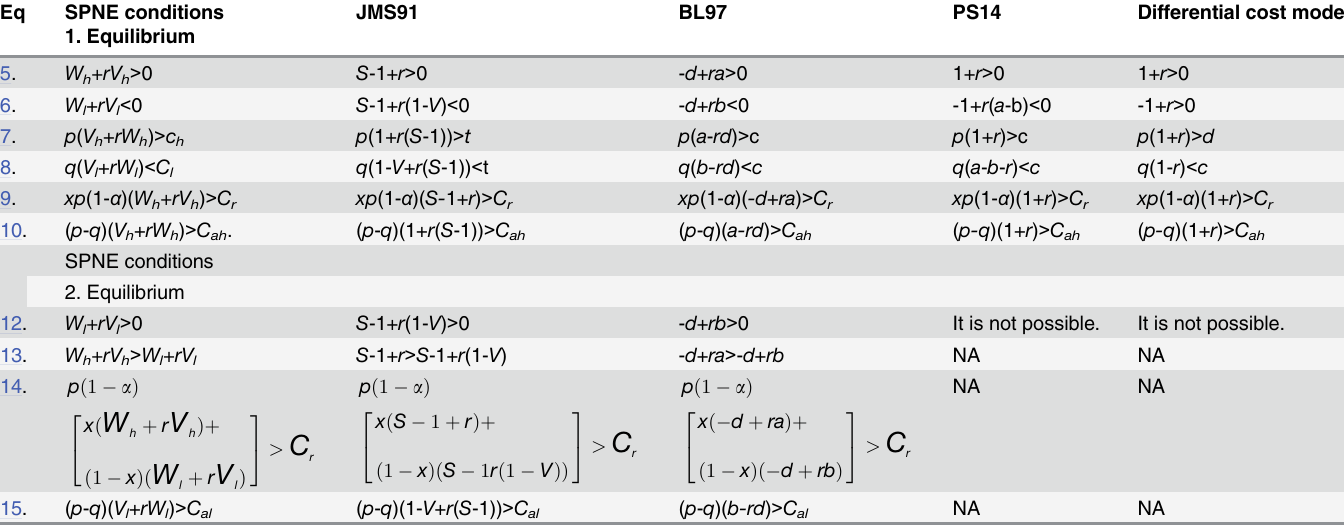
Table 4. SPNE conditions using the parametrization of three different action-response games [4,25, 26]. Eq SPNE conditions Differential cost model 1.